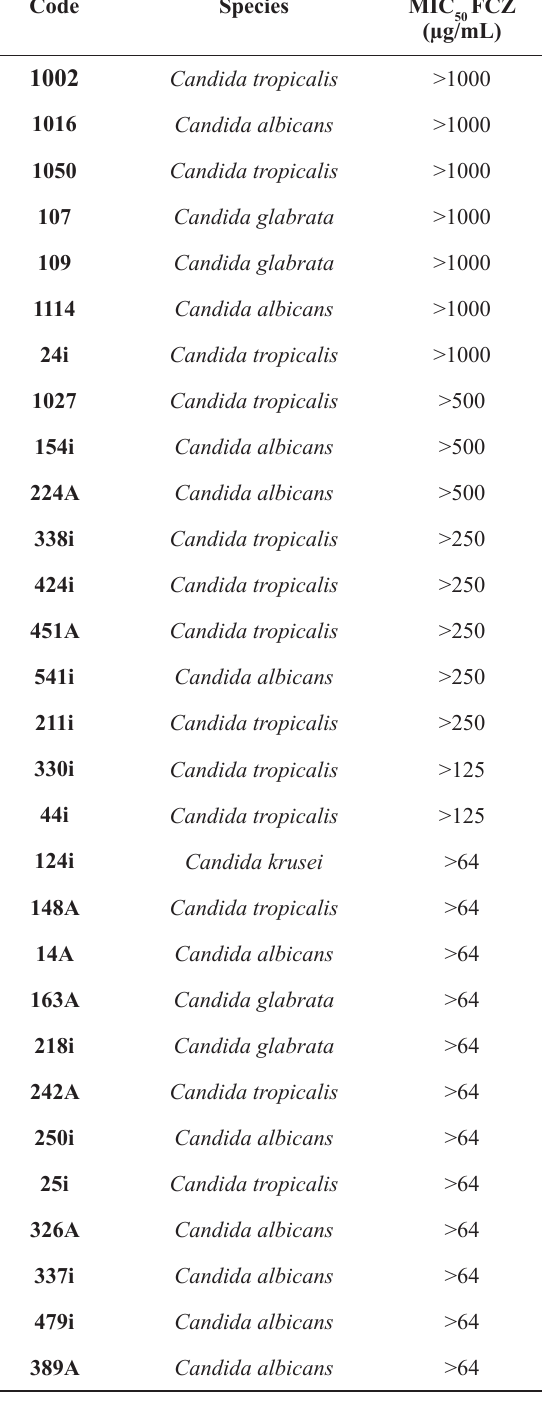
Minimal inhibitory concentration (MIC resistant to FCZ Candida spp. isolates according to CLSI M27-A2